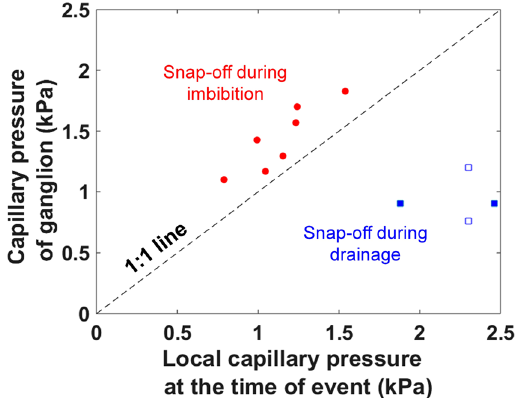
Figure 5. Comparison of local capillary pressures before and after snap-off events in drainage and imbibition. A plot of capillary pressure of trapped ganglia against the local threshold capillary pressure of the connected phase at the time of snap-off for both drainage and imbibition is shown. Data represented by filled symbols are from this work, and the data shown by empty symbols are for supercritical CO 2 -brine system (at 10 MPa and 50 °C) from Andrew et al . 4 .